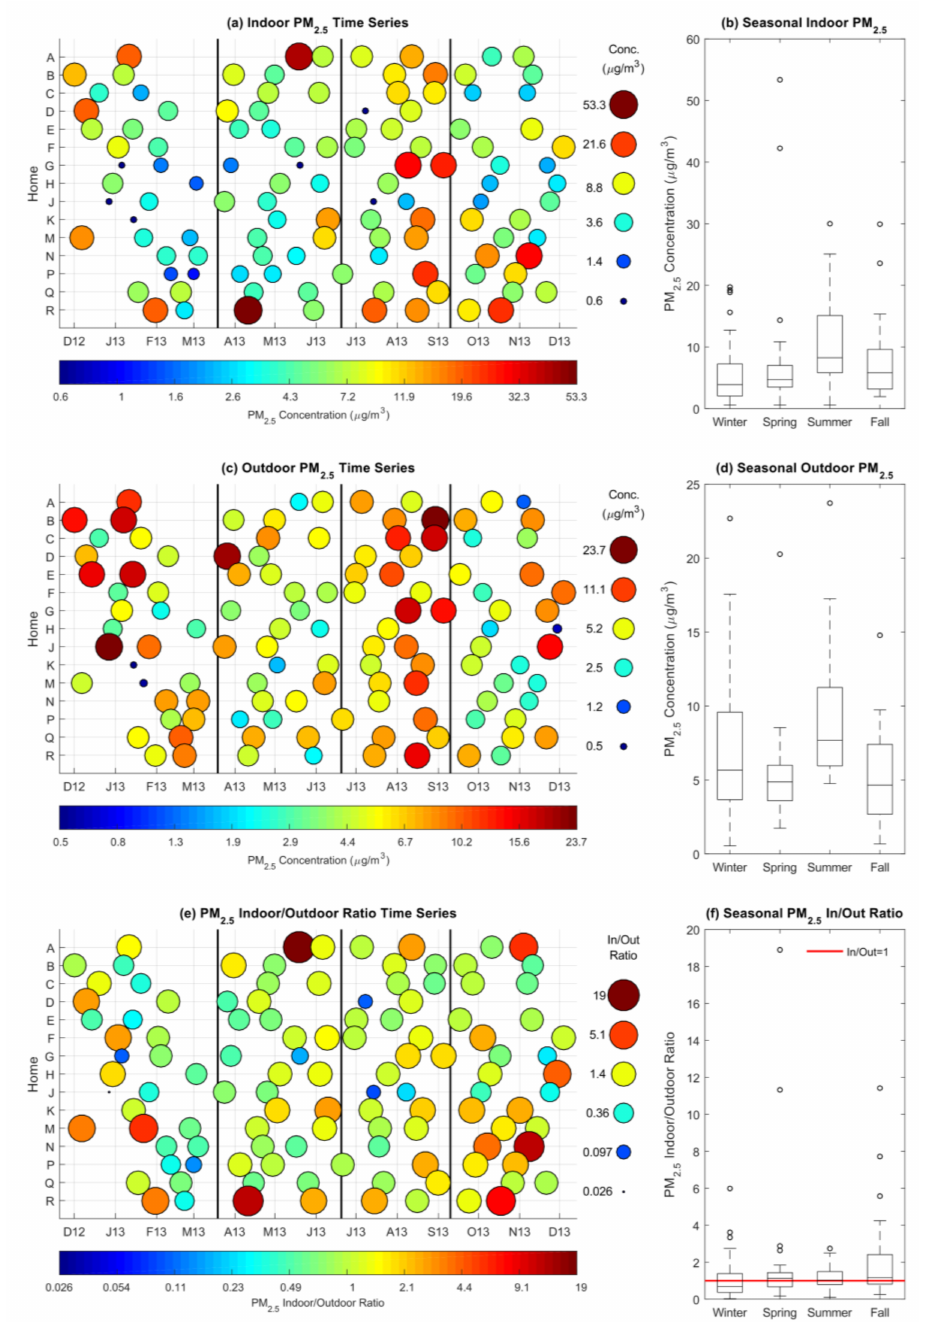
Figure 2. ( a ) Indoor PM 2.5 concentrations; ( b ) box plots of seasonal indoor PM 2.5 concentrations; ( c ) outdoor PM 2.5 concentrations; ( d ) box plots of seasonal outdoor PM 2.5 concentrations; ( e ) PM 2.5 indoor/outdoor ratios; and ( f ) seasonal box plots of PM 2.5 indoor/outdoor ratios (in ( a , c , e ) color and marker size are scaled logarithmically and indicate pollutant values; vertical bars separate